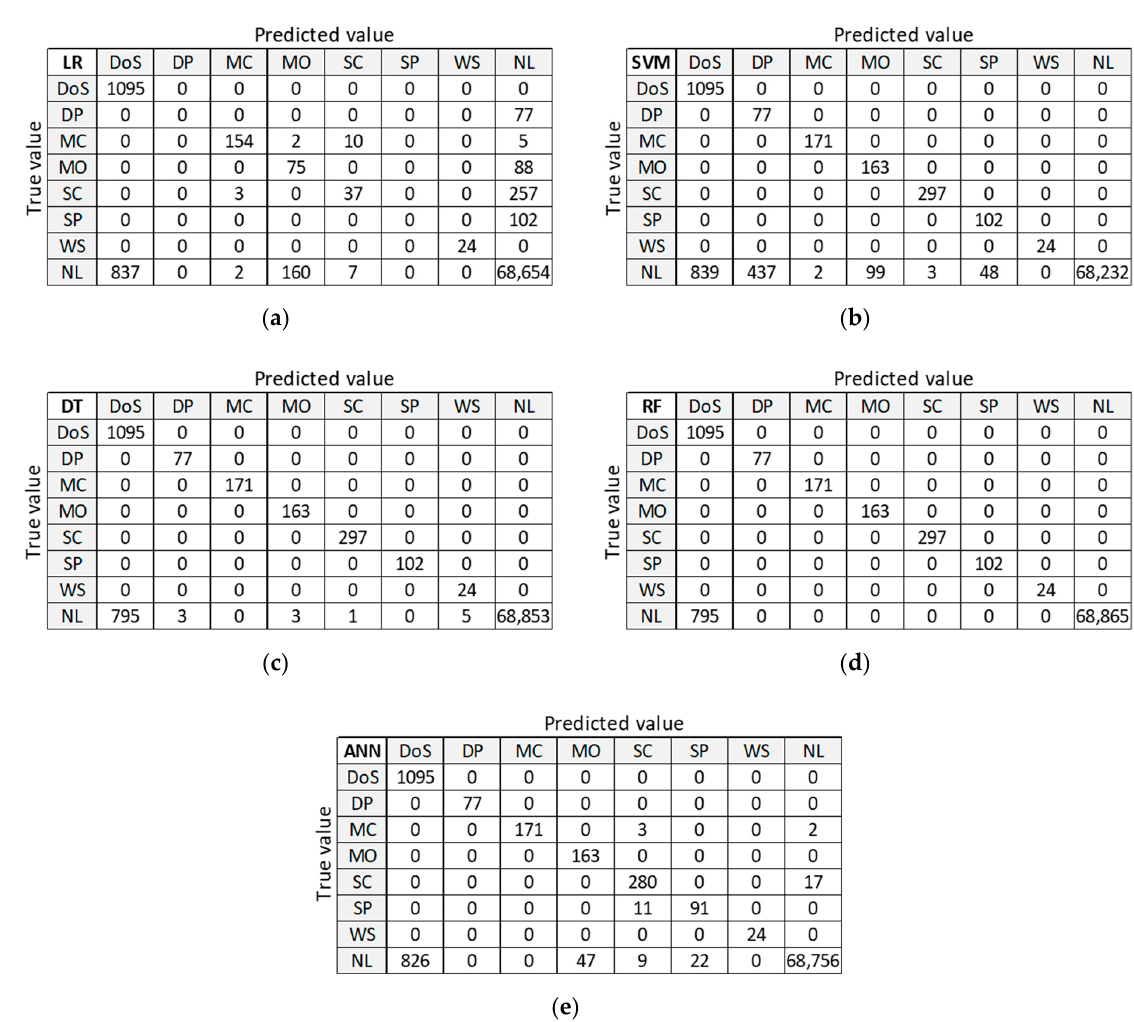
Sensors 2021 , 21 , 4946 16 of 23